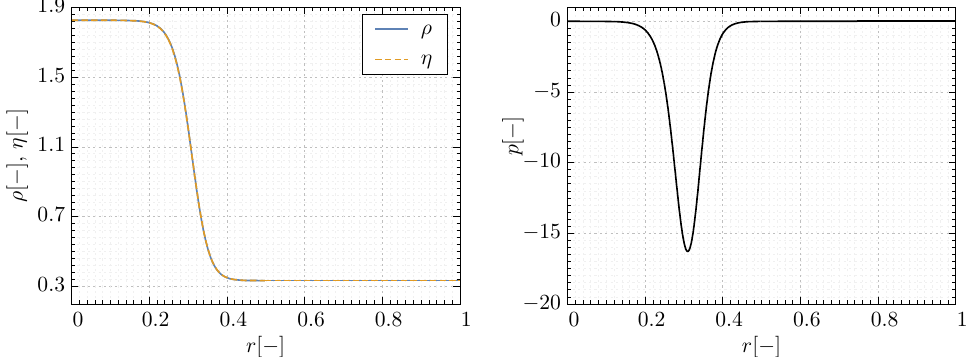
Figure 4. Boundary value problem reference solution for the HNSK system. The left figure shows the radial profiles of ρ and η while the right one shows the radial profile of the gradient field, for α = 10 − 2 and γ = 10 − 3